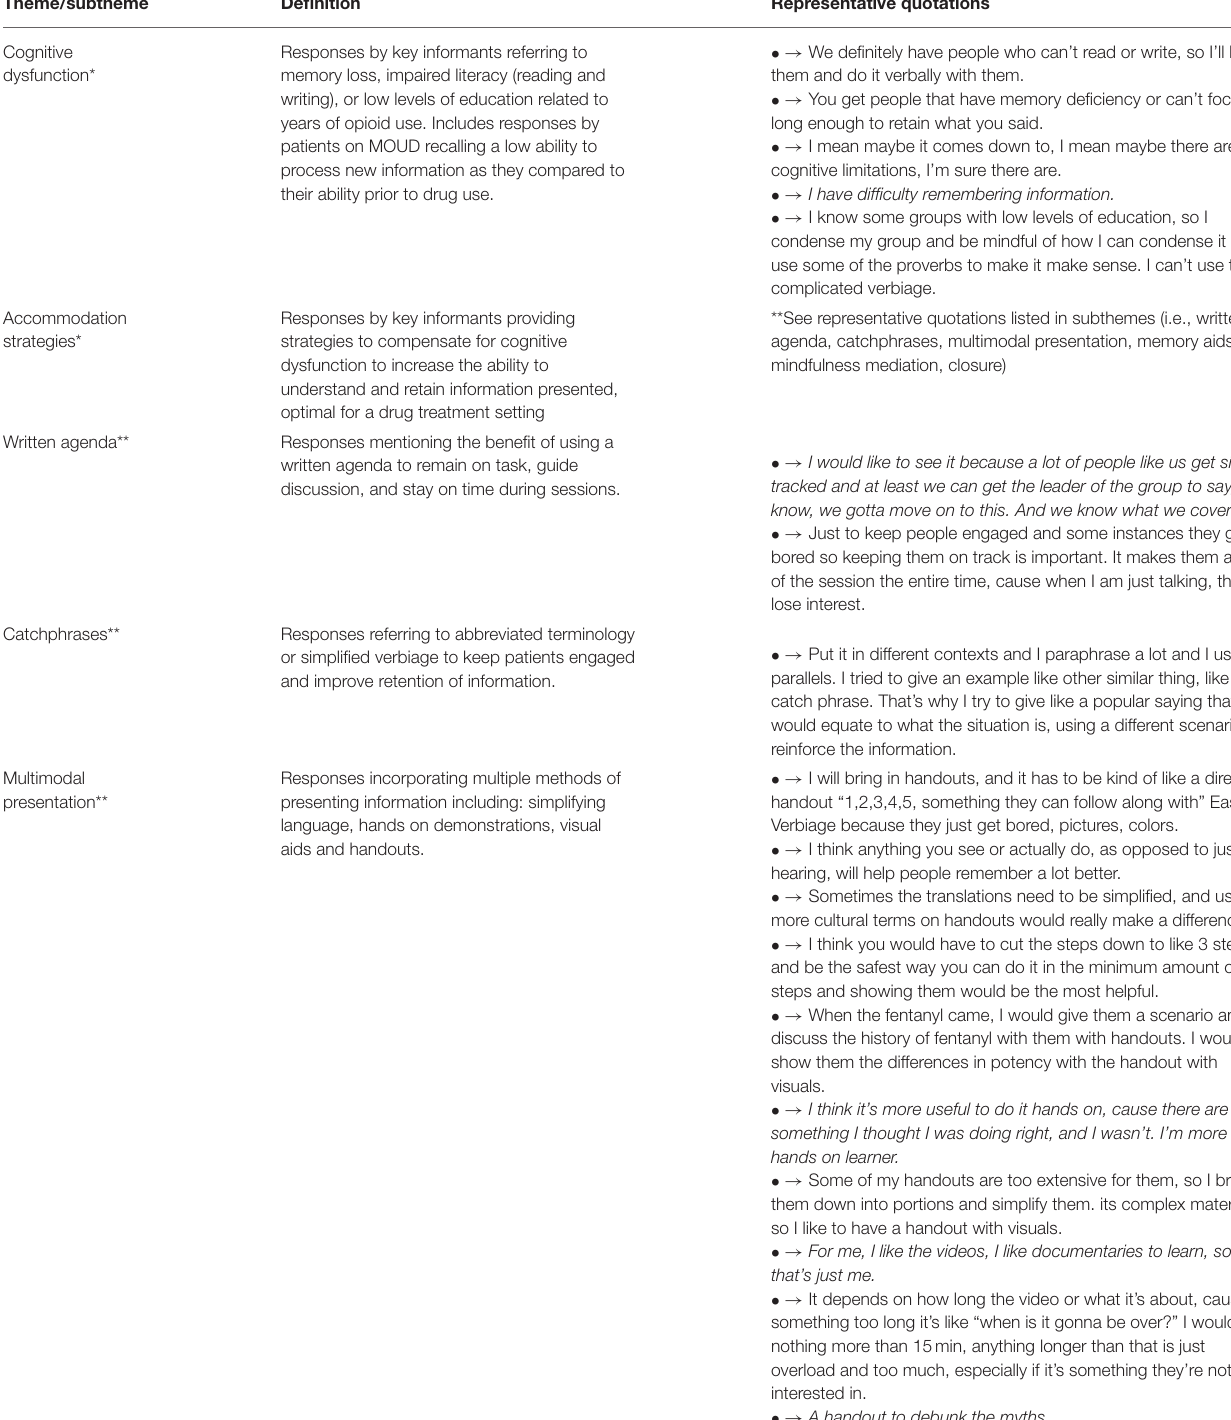
TABLE 1 | Emerging themes and subthemes of focus group discussions with drug treatment providers and patients on medication for opioid use disorder (MOUD).